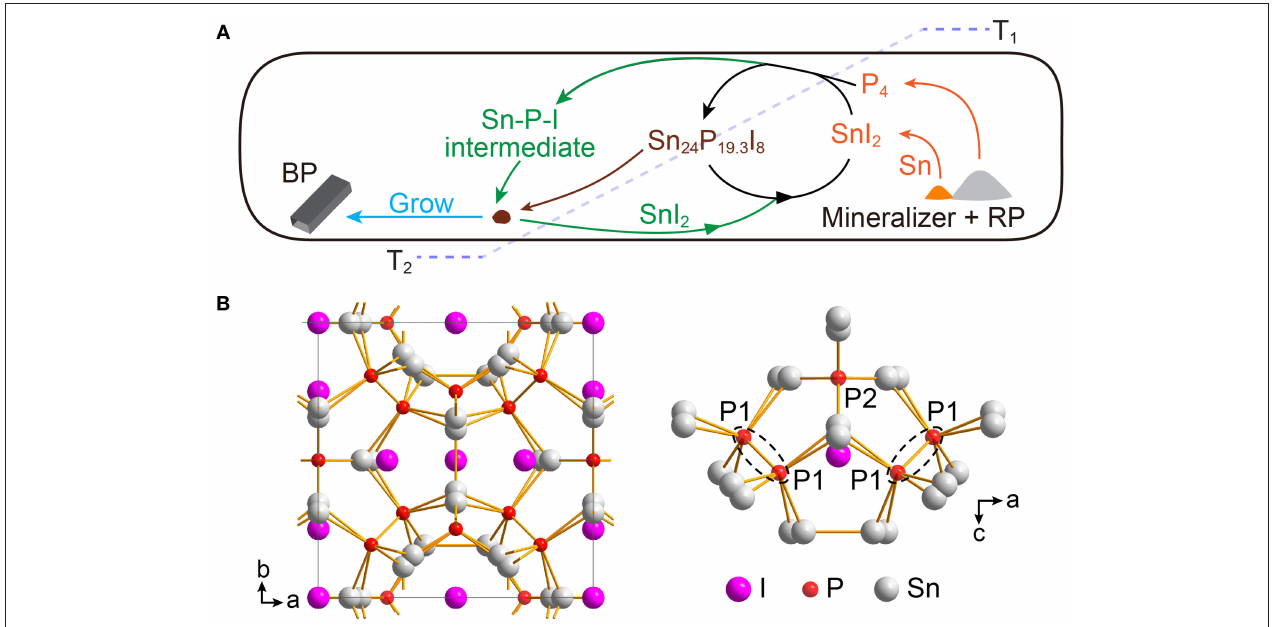
FIGURE 5 | (A) Schematic illustration of the proposed mechanism of BP growth in the Sn-I assisted reaction. The mineralizer and red phosphorus (RP) first form SnI 2 , P 4, and Sn at high temperature (T 1 ) (orange colored arrows). The resulting SnI 2 , P 4, and Sn then react to yield Sn 24 P 19.3 I 8 which can deposit at the place with relatively low temperature (T 2 ) (brown colored arrow). Subsequently, the BP crystals can grow with the assistance of SnI 2 (green colored arrows). (B) Crystal structure of Sn 24 P 19.3 I 8 where Sn and P atoms form a three dimensional framework with I atoms as